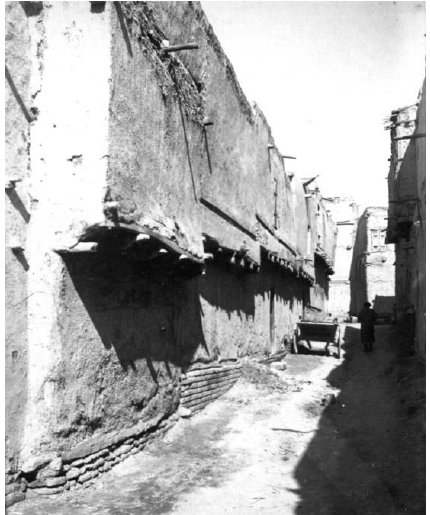
Figure 3. Street façade of traditional Bukharian houses.